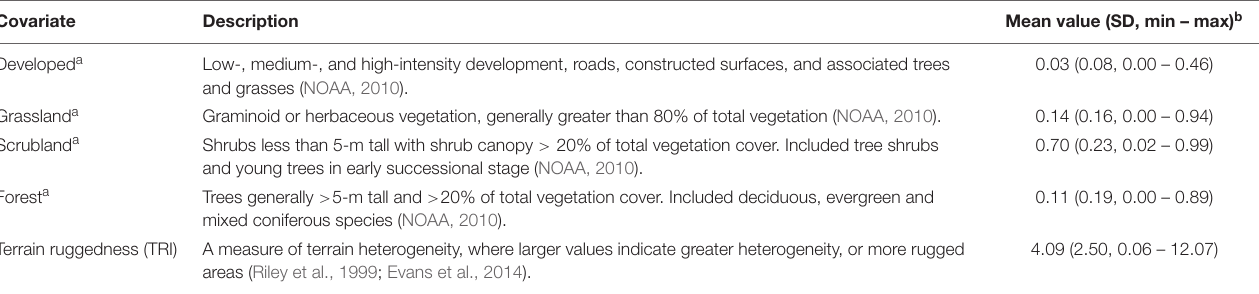
TABLE 1 | Landscape covariates used to characterize spatial variation in site occupancy of territorial pairs of Golden Eagles in coastal southern California, United States, 2016 – 2017.